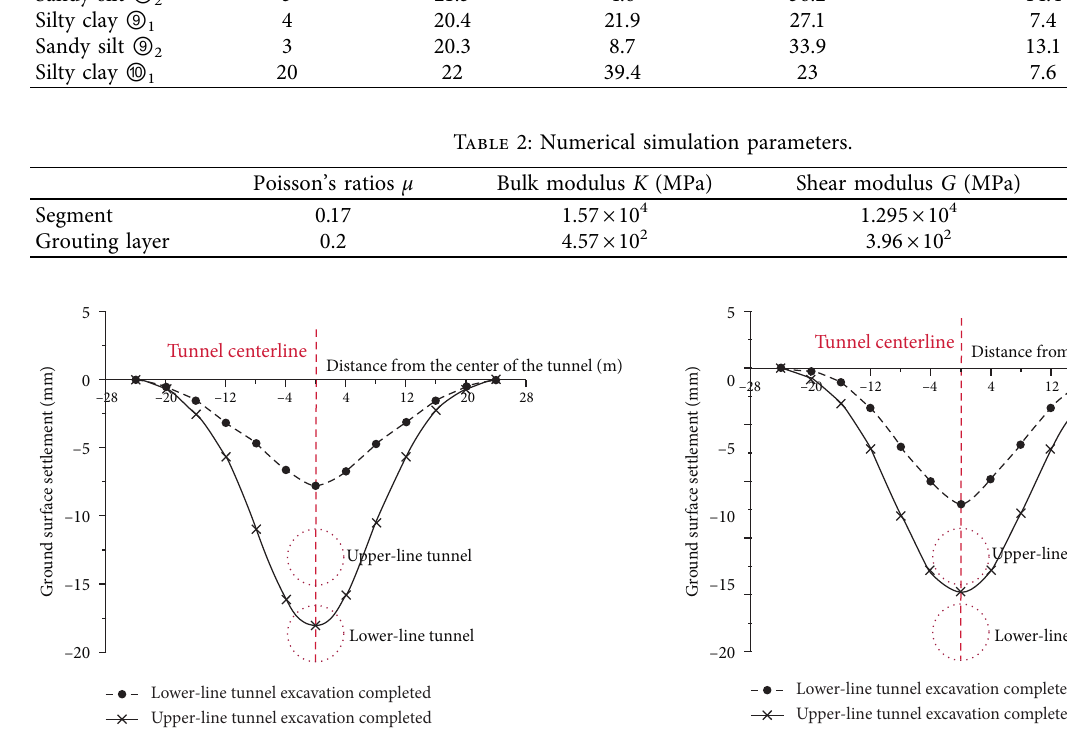
Figure 6: First up and then down construction sequence surface settlement